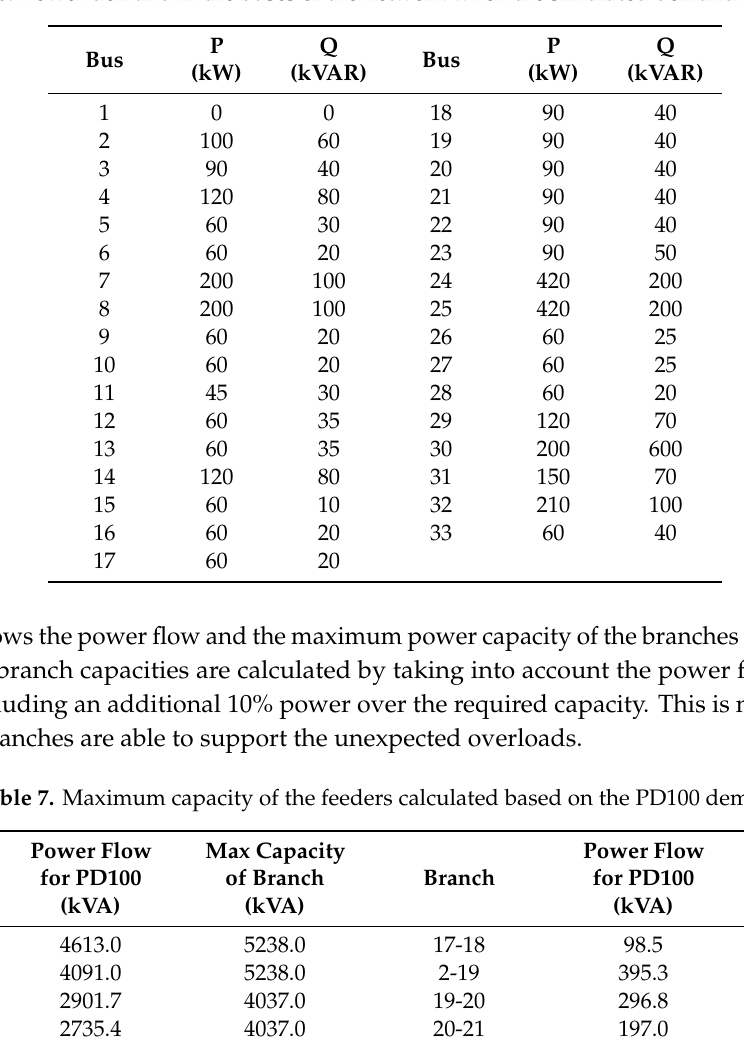
Table 6. Power demand in the buses of the network when the simulated demand is PD100.